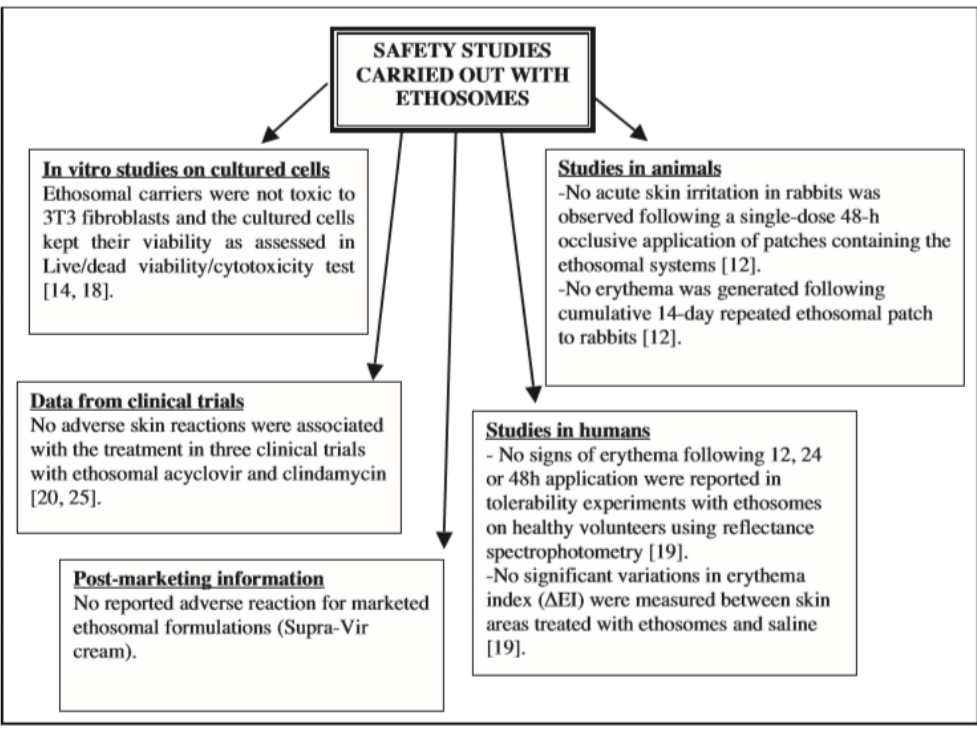
Figure 6. Safety studies carried out with ethosomes. Reproduced from Reference [24] with permission